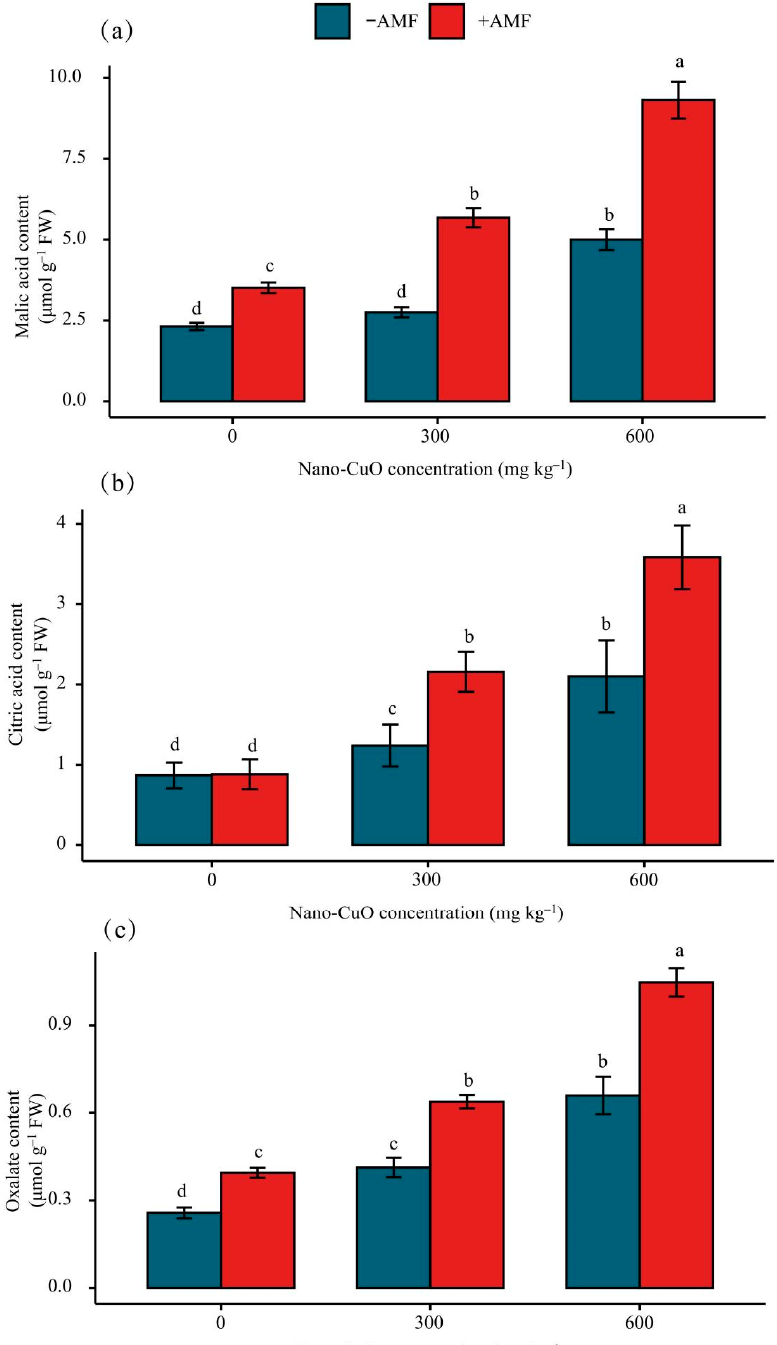
Figure 6. The function of AMF in the secretion of citric acid ( a ), malic acid ( b ), and oxalate ( c ) in C. indica roots in response to nano-CuO stress. Different lowercase letters show significant differences between treatments ( p < 0.05).